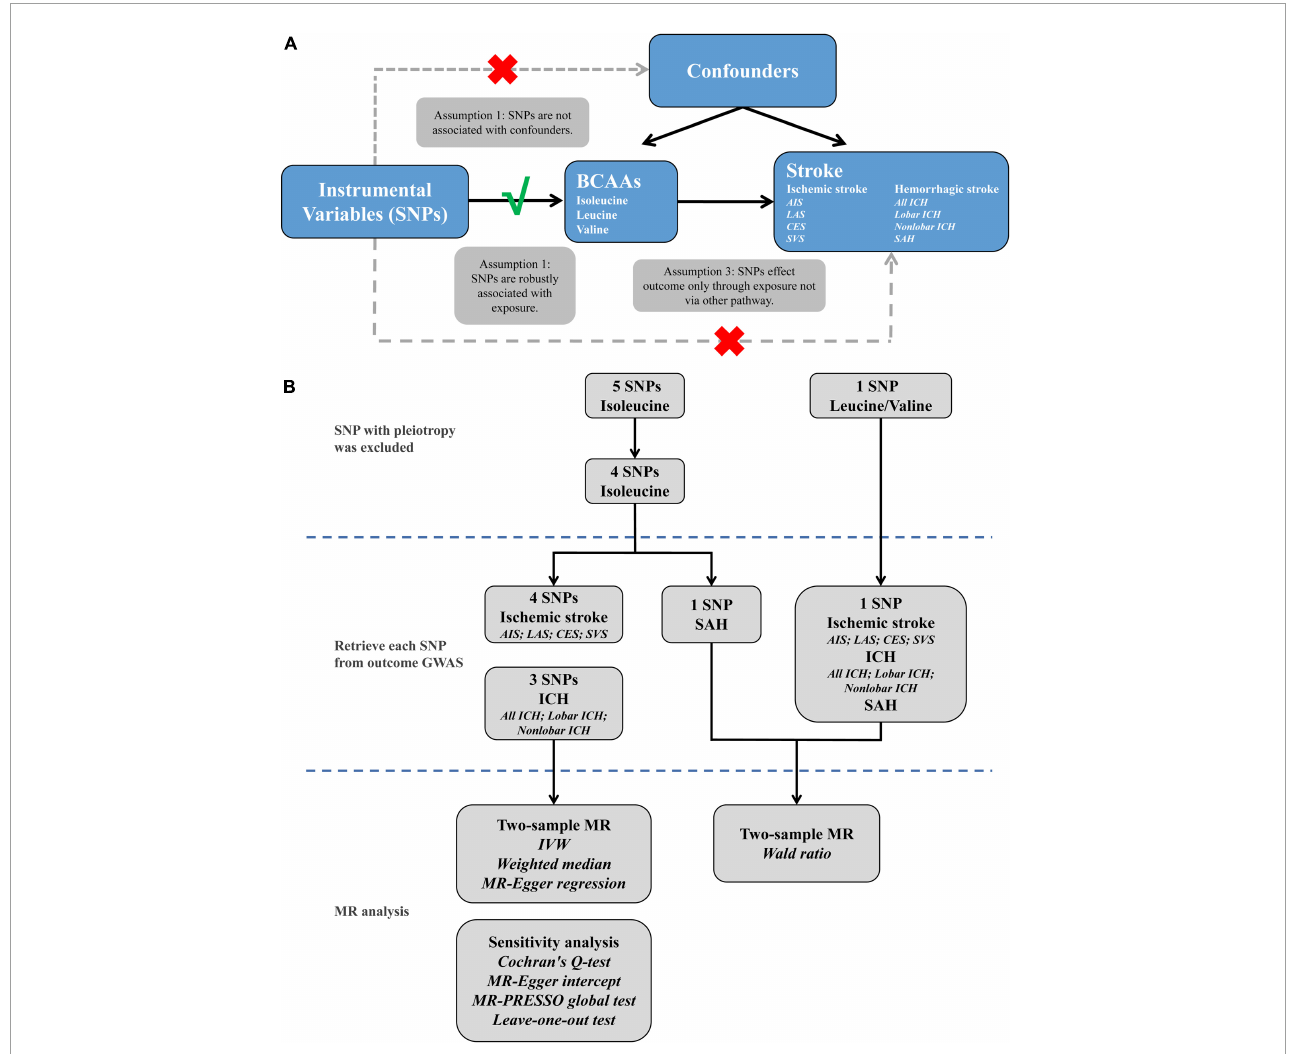
FIGURE1 The explanation (A) and study flame chart (B) of Mendelian randomization analysis for BCAAs and risk of stroke. SNPs, single nucleotide polymorphisms; BCAAs, branched-chain amino acids; AIS, any ischemic stroke; LAS, large artery stroke; CES, cardioembolic stroke; SVS, small vessel stroke; ICH, intracerebral hemorrhage; SAH, subarachnoid hemorrhage; GWAS, genome-wide association studies; MR, Mendelian randomization; IVW, inverse variance weighted; MR-PRESSO, MR pleiotropy residual sum and